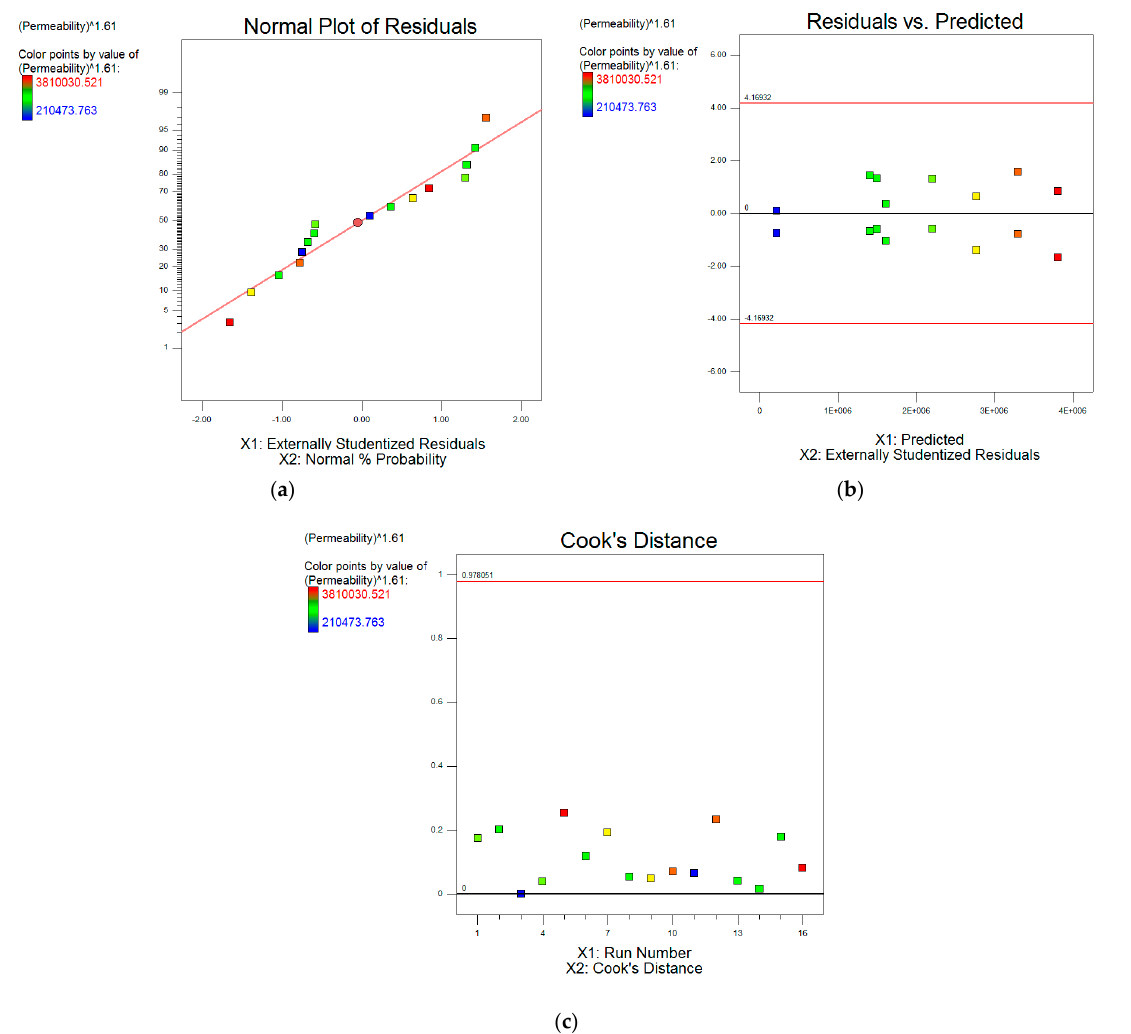
Figure 16. Model diagnostics plots: ( a ) normal probability plot; ( b ) residuals versus predicted response; ( c ) Cook’s distance vs. the